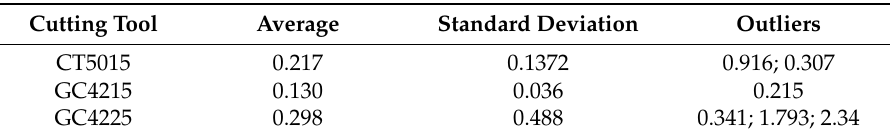
Table 5. Outliers of the cutting tool